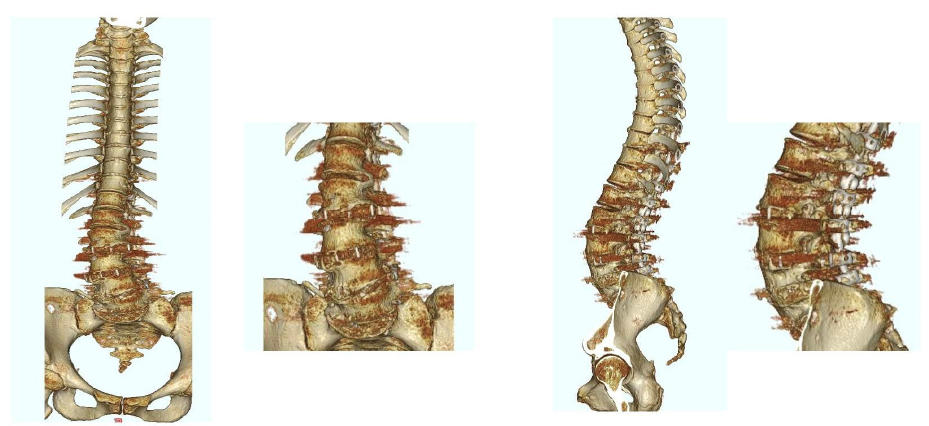
Figure 4. Postoperative 3D CT image of the same patient as in Figure 3. The patient underwent LLIF at L2/3, L3/4, and L4/5 using PEEK cages.